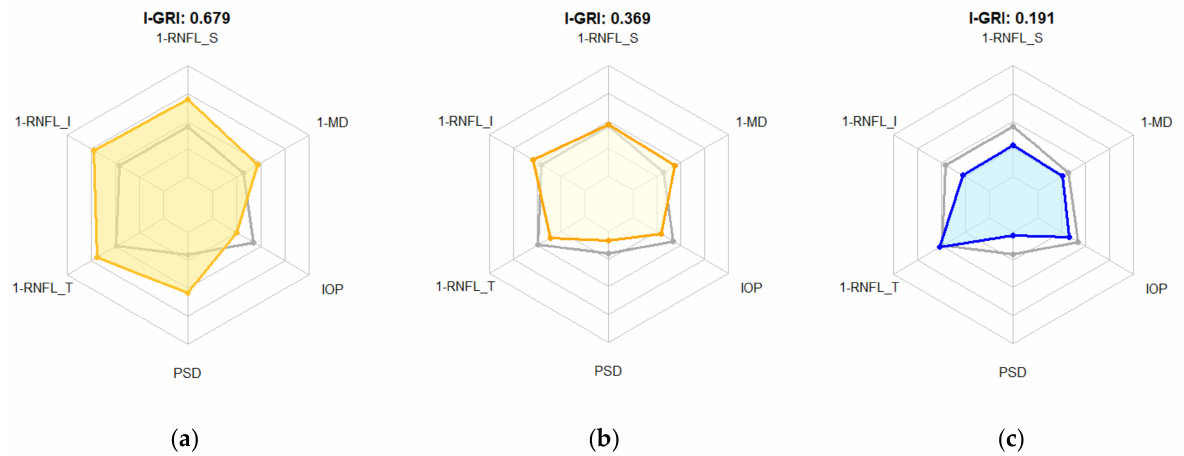
Figure 6. Boxplot of the I-GRI values for the reference dataset. ( a ) Glaucoma; ( b ) border section; ( c ) normal.